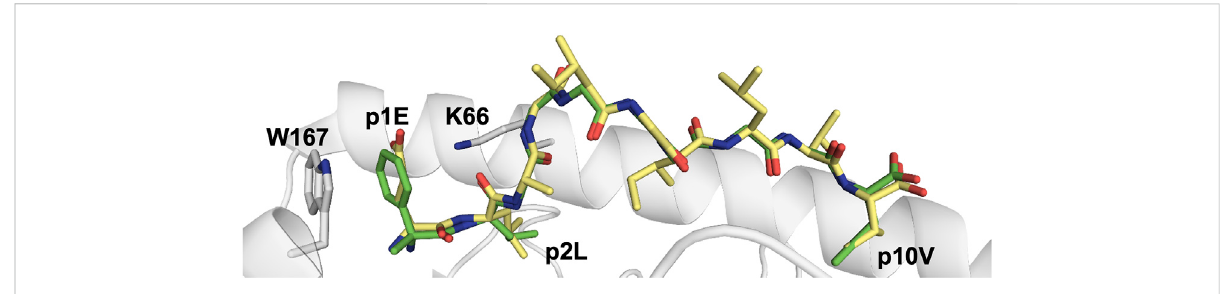
FIGURE 8 Replacement of three residues in the HLA-A*02:01-restricted melanoma epitope Mart-1 with unnatural amino acids did not alter the conformationwhileenhancingbindingaf fi nity.Comparisonofthecrystalstructureofthewild-typeMart-1peptideELAGIGILTV(1JF1.pdb,grey)with the APL in which p1E, p2A and p10V were modi fi ed to phenylglycine, norvaline and PRG, respectively (4WJ5. pdb, green) (Hoppes et al., 2014). Two HLA-A*02:01 residues that interact with the modi fi ed residues in the APL are also